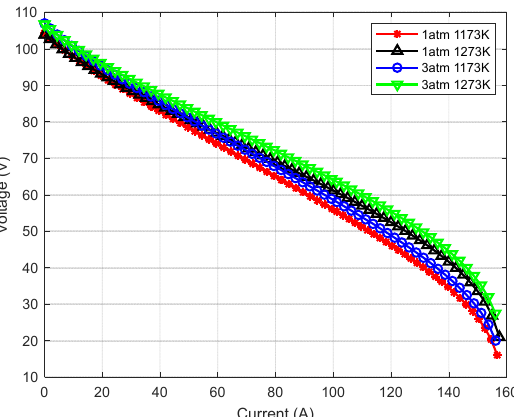
Figure 12. Datasets for 5kW cell stack under various operating scenarios. Table 3. The size of dataset.